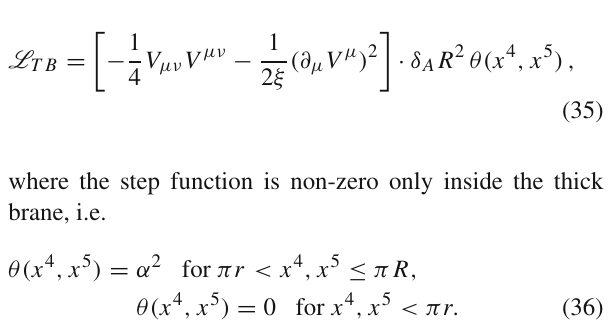
The BLKT with gauge fixing term is